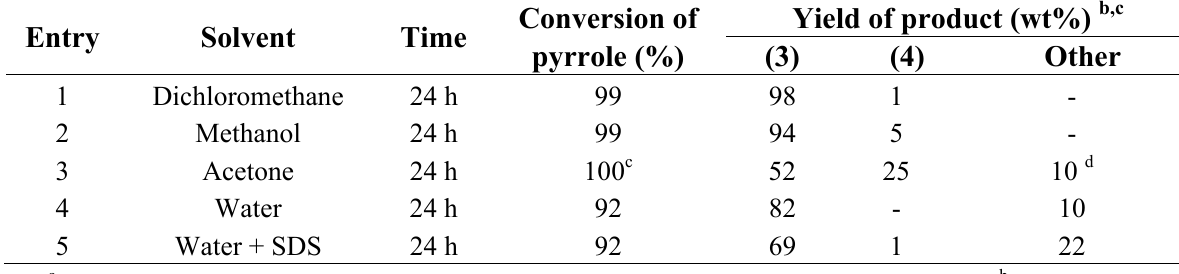
Table 4. Reaction of pyrrole and acetone in presence of reduced graphene oxide a